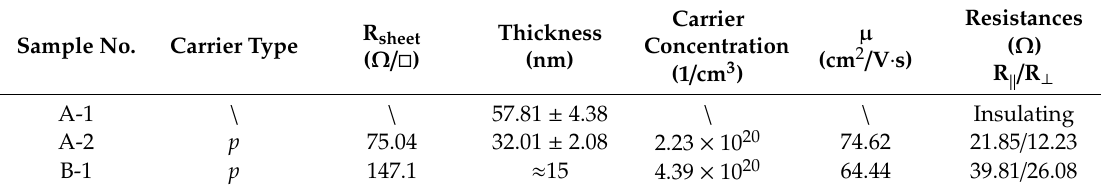
Table 2. Electrical properties of sample A-1, A-2, and B-1 resistances are measured from two orthogonal directions of a square-shaped